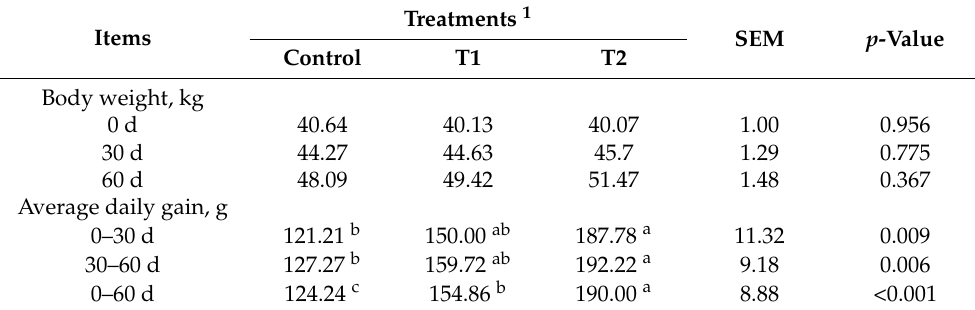
Table 2. Effect of Bacillus licheniformis and the combination of probiotics and enzymes on body weight of yak